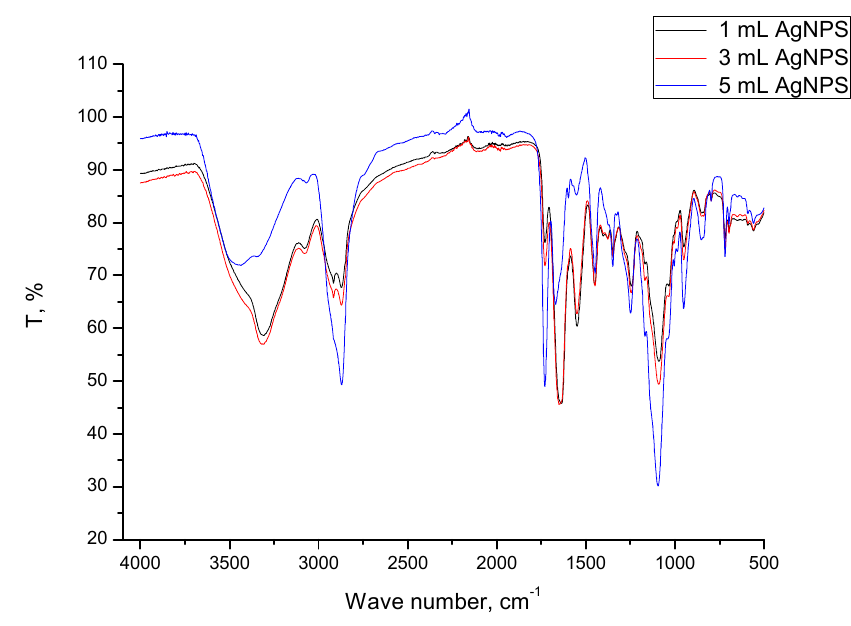
Figure 6. FT-IR spectra of Beetosan ® hydrogels modified with nanoparticles. Table 1. Vibrations of groups presented in tested hydrogels.